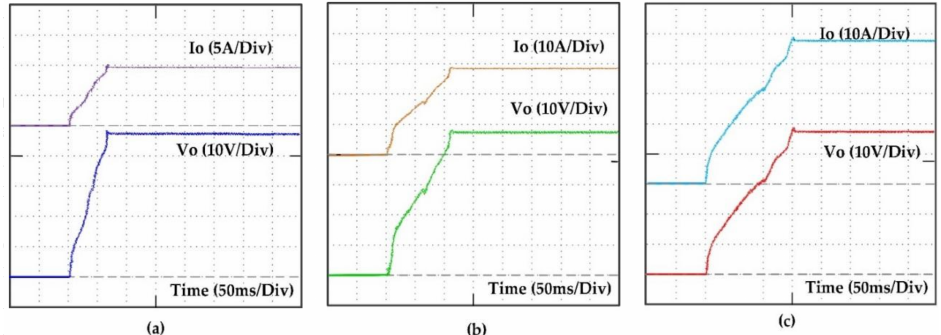
Figure 16. The output current and voltage waveform of DAB-IBDC converter during soft-start period while various resistive loads connected to the circuit. ( a ) 2.5 Ω resistive load at 500 W converter ( b ) 1.65 Ω resistive load at 1.5 kW converter and ( c ) 1 Ω resistive load at 2.5 kW